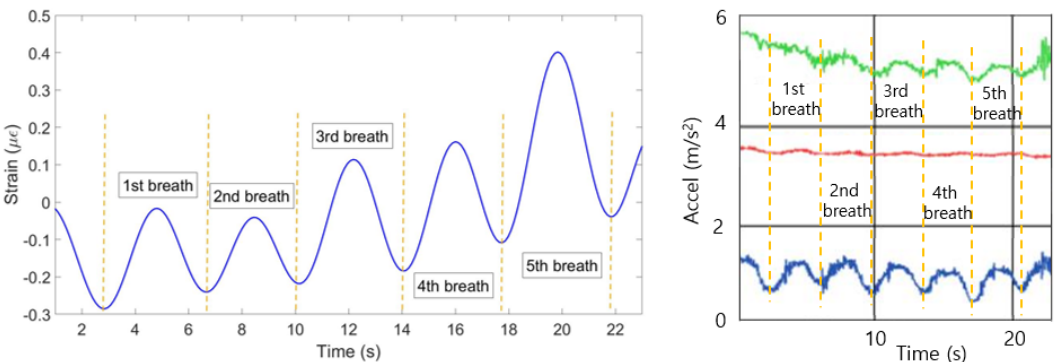
Figure 15. Breathing pattern for the first volunteer in the sitting position reconstructed based on the 10 FBGs strain patterns ( left ) and obtained from the reference sensor ( right ).